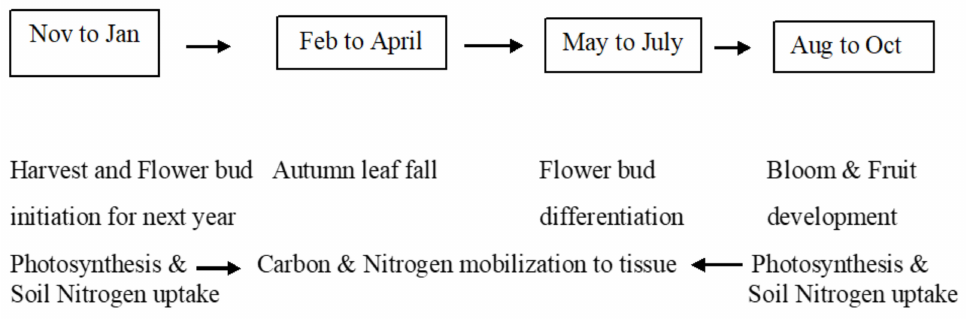
Figure 1. Australian cherry stage of development and physiological